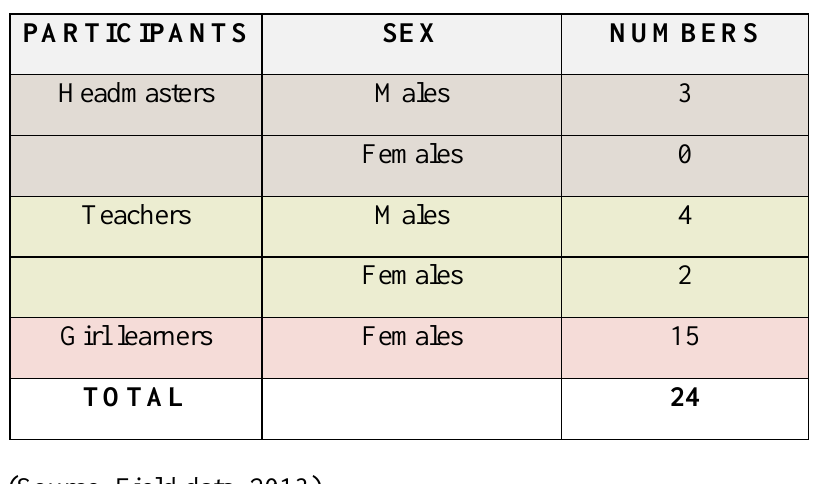
Table 5.5: Demographic data as extracted from the